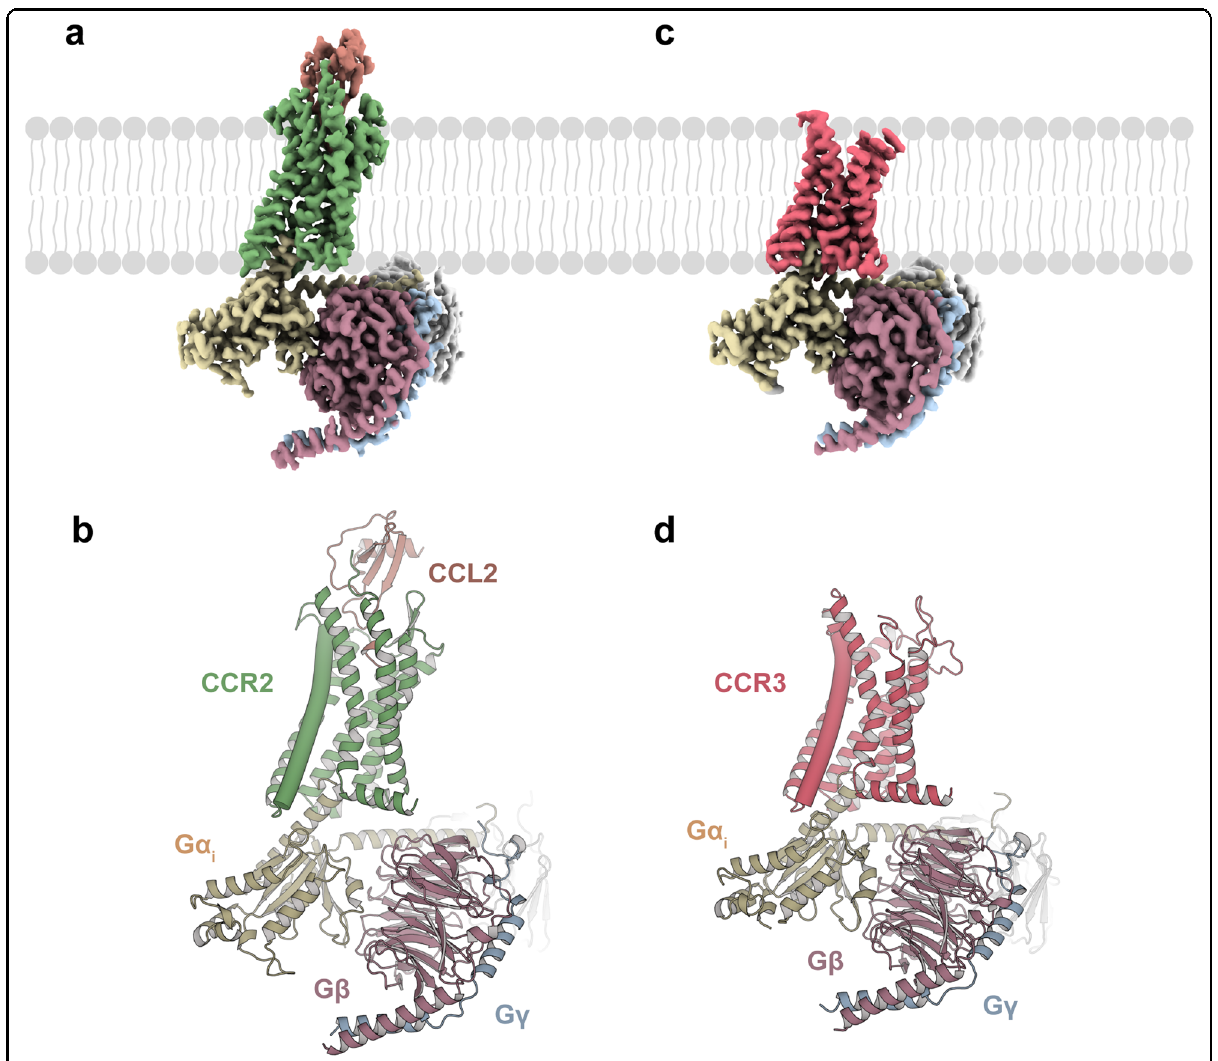
Fig. 1 Cryo-EM structures of the CCL2 – CCR2 – G i and apo CCR3 – G i complexes. a , c Cryo-EM density maps of the CCL2 – CCR2 – G i ( a ) and apo CCR3 – G i complexes ( c ). b , d Models of the CCL2 – CCR2 – G i ( b ) and apo CCR3 – G i complexes ( d ). Rosy brown, G β ; light blue, G γ ; gray, scFv16; green, CCR2 ( a , b ); pink, CCR3 ( c , d ); yellow, G α i1 ; brown, CCL2 ( a , b